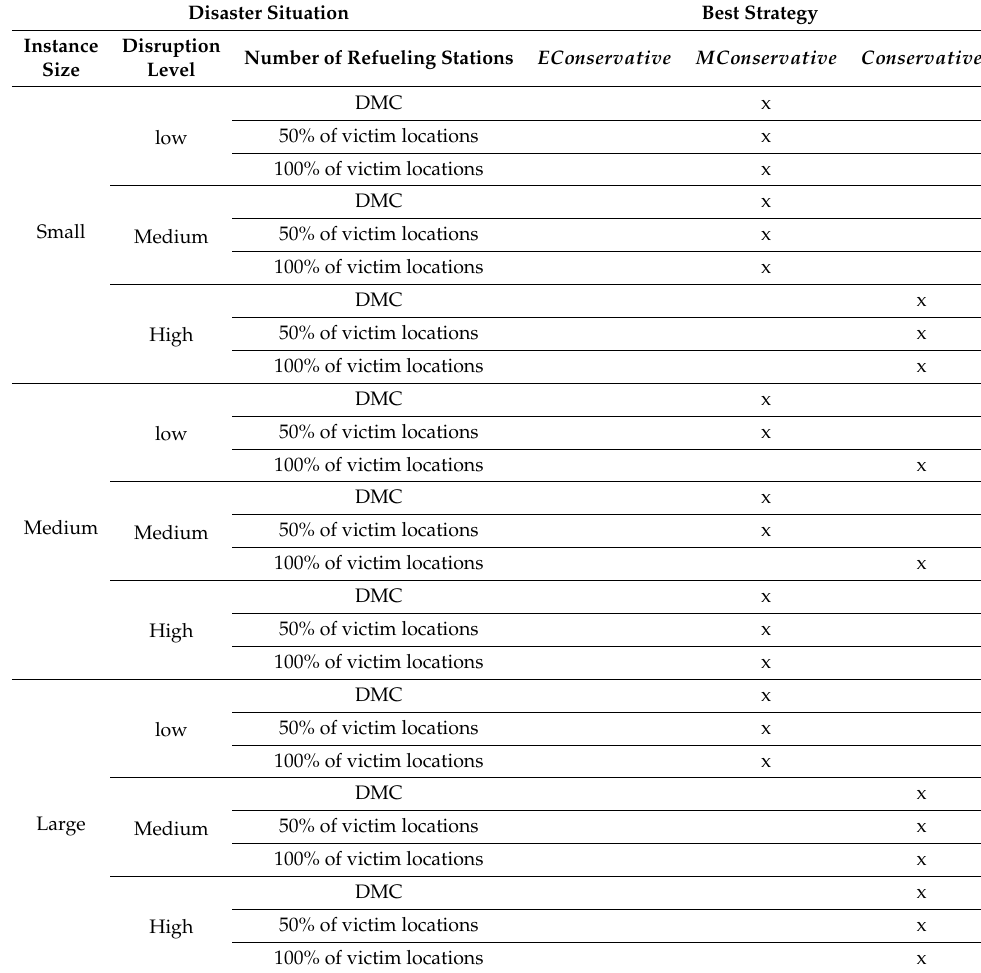
Table 3. Consolidation of the best combination of refueling strategies and number of refueling stations